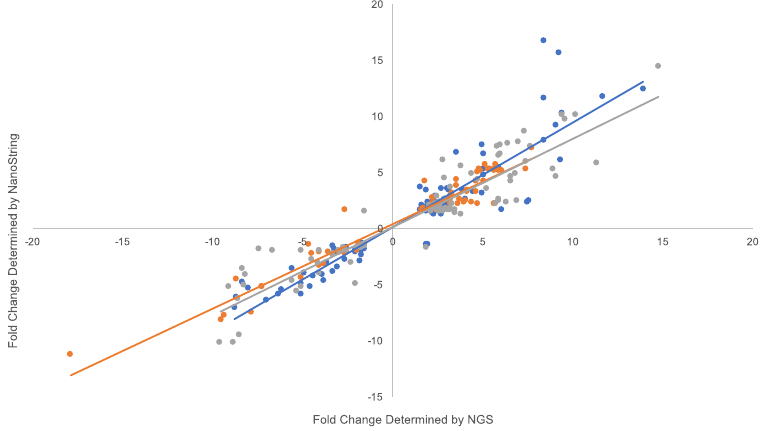
Figure 2. NanoString nCounter technology was used to confirm the fold changes determined using EdgeR in skin (blue), brain (orange) and liver (gray).